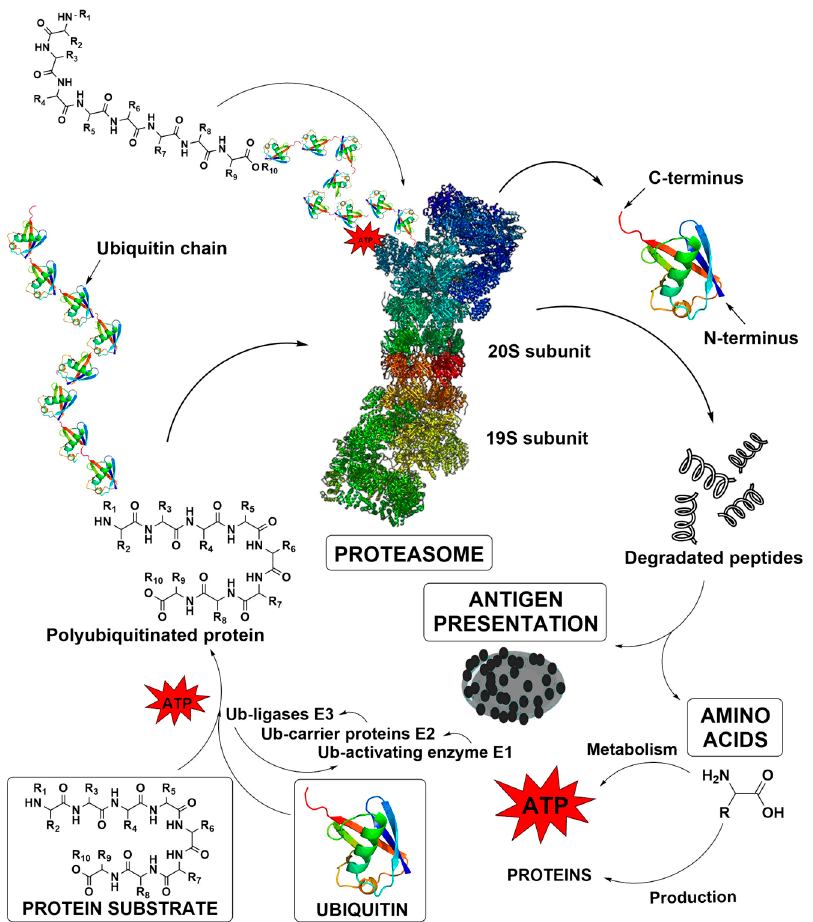
Figure 1. The ubiquitin – proteasome pathway in protein degradation [7–9]. The ubiquitination cascade is triggered by the ATP-mediated conjugation of a target protein with a single ubiquitin molecule by the Ub-activating enzyme E1. This tagged protein is then transferred to the Ub-carrier proteins E2 that subsequently forms a complex with Ub-ligases E3. The ligases recognize the protein and perform a sequence of ubiquitin additions until the final polyubiquitinated protein is formed. Finally, in human a rapid degradation of ubiquitinated protein by the proteasome is executed at six proteolytic sites of the enzyme. The degradation process results in 3 to 25 amino acids-long peptides, which are quickly digested into amino acids or can serve as antigen presentation molecules.